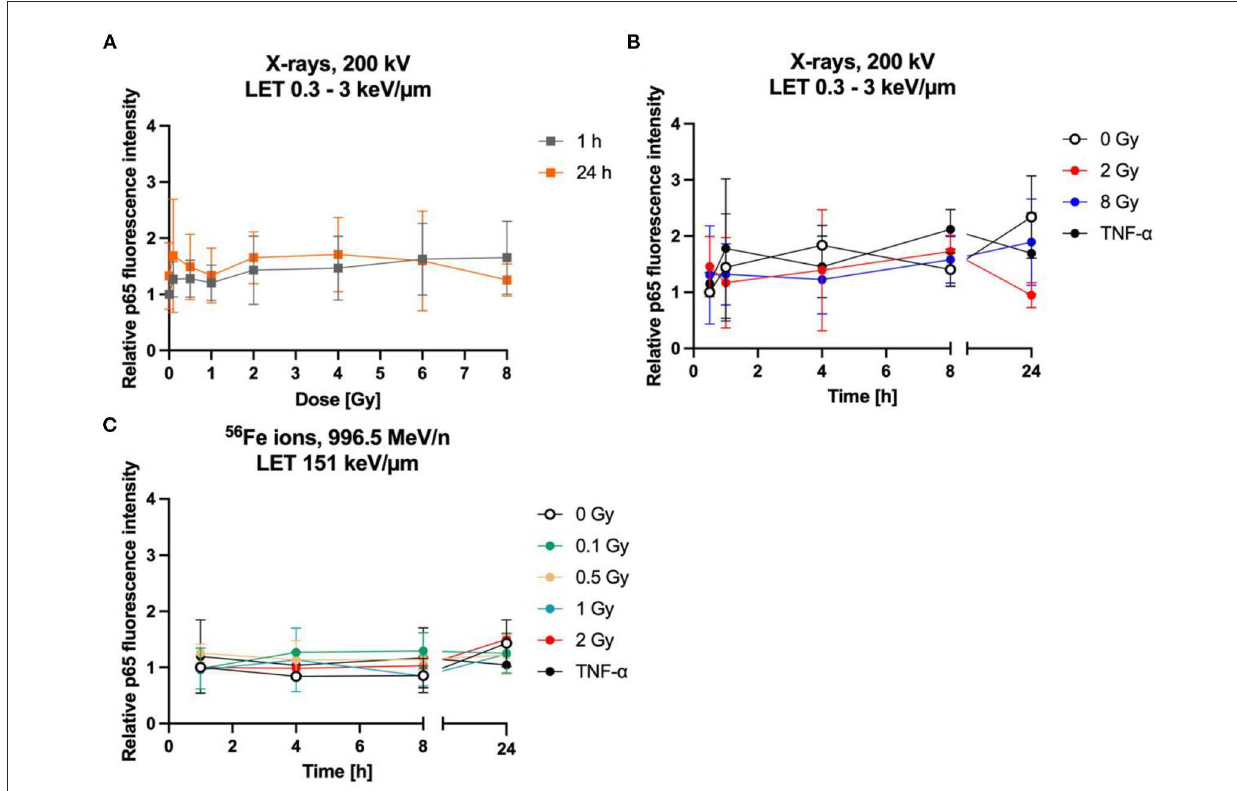
FIGURE9 The NF- κ B pathway is not activated by radiation exposure in astrocytes. Astrocytes were exposed to X-rays (A, B) or iron ions (C) and fixed at time points up to 24h after irradiation for immunofluorescence staining of the NF- κ B subunit p65. (A) Dose effect curves of activation of NF- κ B pathway (p65) after exposure to X-rays ( n = 6). (B) The relative fluorescence intensity of p65 in the nucleus area for different doses of X-irradiation over a time period up to 24h, showing a basal activity of the NF- κ B pathway but no further significant induction by radiation exposure or incubation with TNF- α . The samples were compared via Tukey’s multiple comparison test, based on a sample size of n = 3. (C) Exposure to different doses of 56 Fe ions (LET 151 keV/ µ m, 996.5 MeV/n) did not induce any further activation of NF- κ B pathway ( n = 2). The relative fluorescence intensity of p65 in the nucleus area was calculated by normalizing the raw integrated density for each treatment to the raw integrated density of the untreated control at the earliest time point that was investigated. Data are shown as mean ±